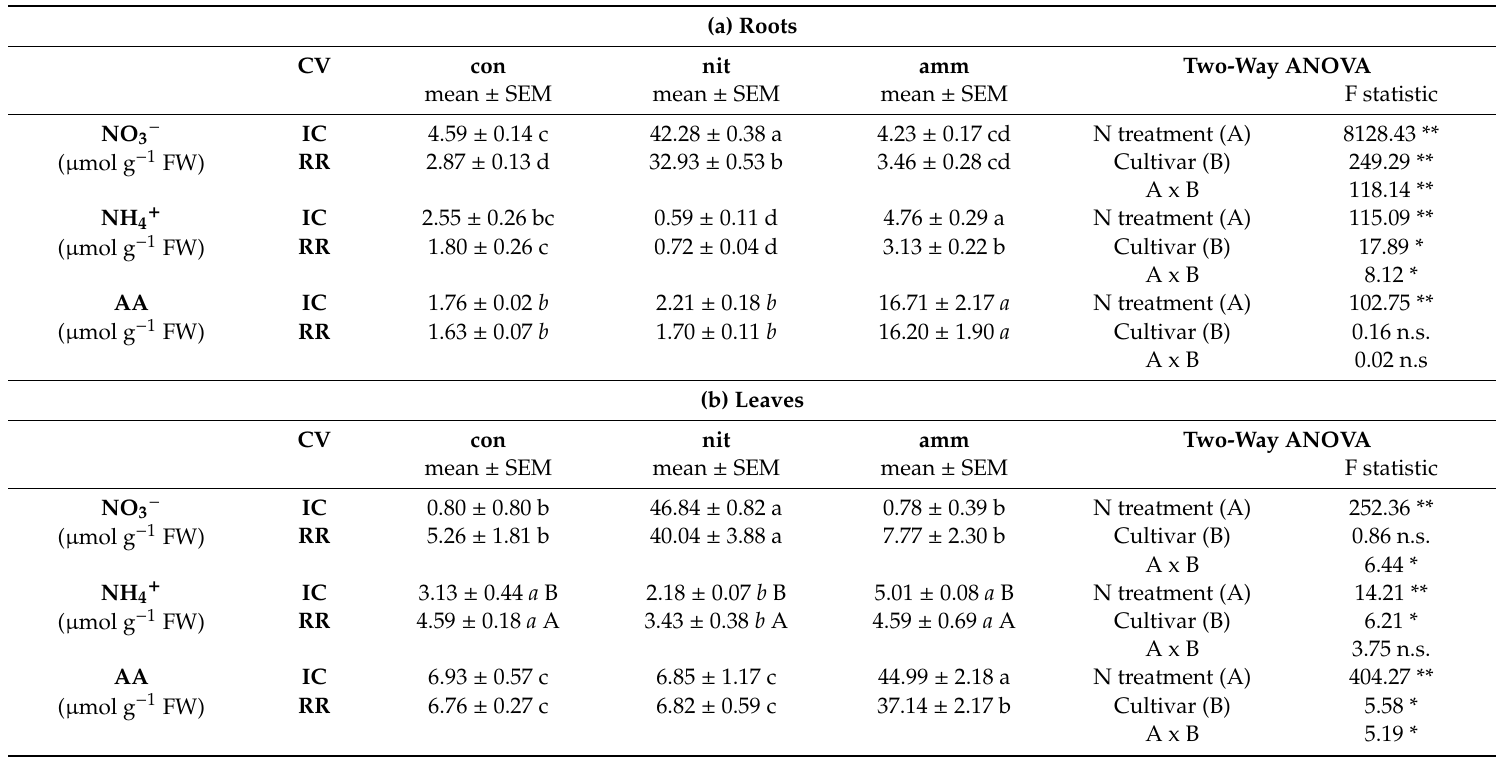
Table 1. Evaluation of plant N nutritional status by determination of the contents of NO 3 − , NH 4 + , and total amino acids in roots ( a ) and leaves ( b ). Basil plants of the green ‘Italiano Classico’ (IC) and of the purple ‘Red Rubin’ (RR) cultivars were exposed for 5 d to absence of N—control [con], 10 mM NO 3 − —nitrate [nit],